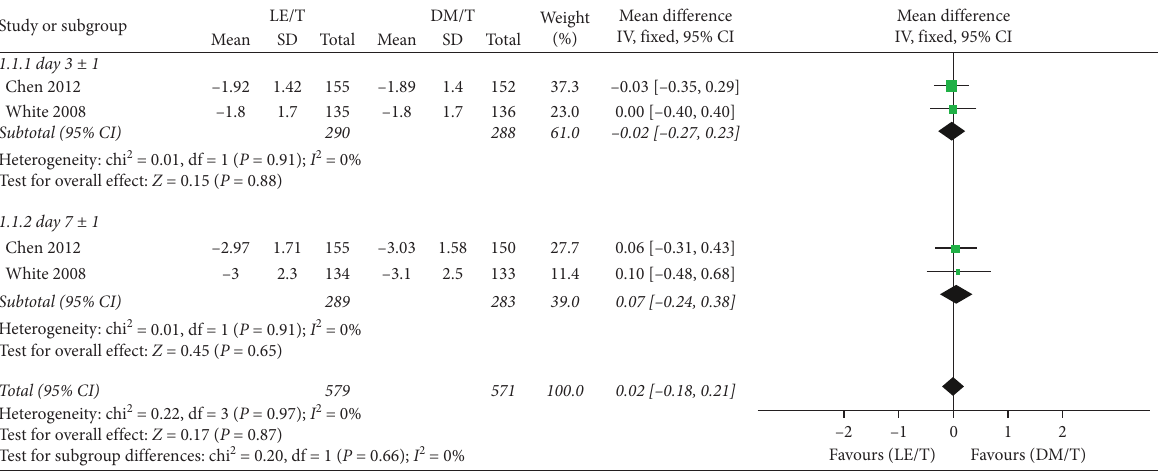
Figure 6: Forest plot of CFB in conjunctivitis signs composite score.